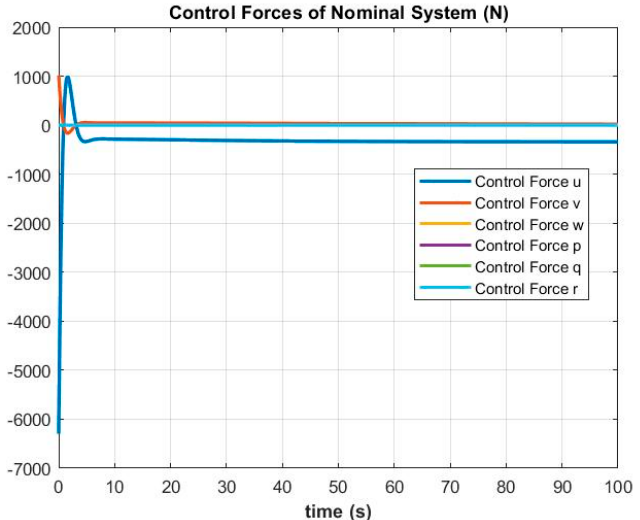
Figure 7. The error in satisfaction of the constraint equation ϕ 2 s = x 2 − y = 0. The plot in Figure 6 shows the error in the satisfaction of constraint Equation (20).